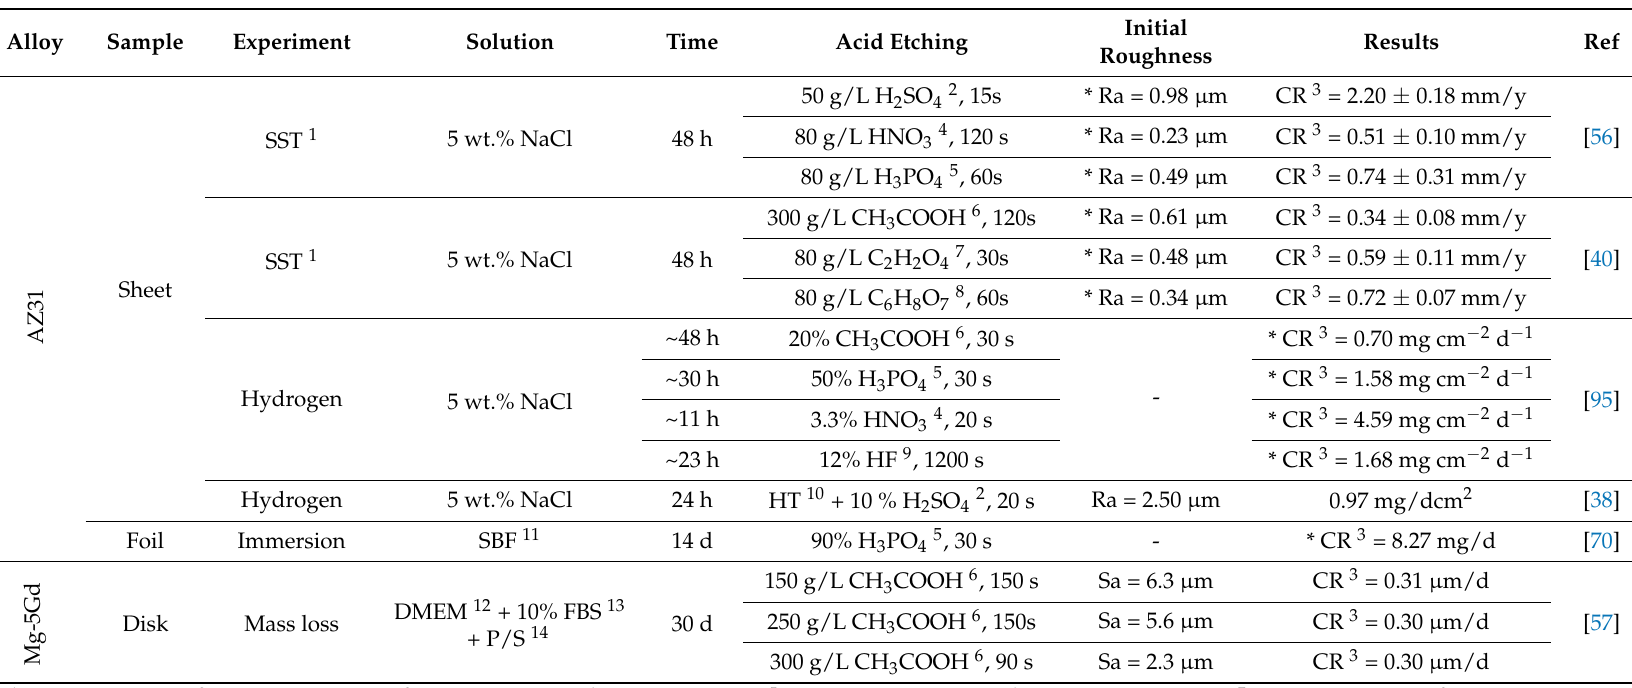
Table 3. List of different studies on acid etching being used as a surface treatment. * Values were determined from the diagram with the corresponding reference.